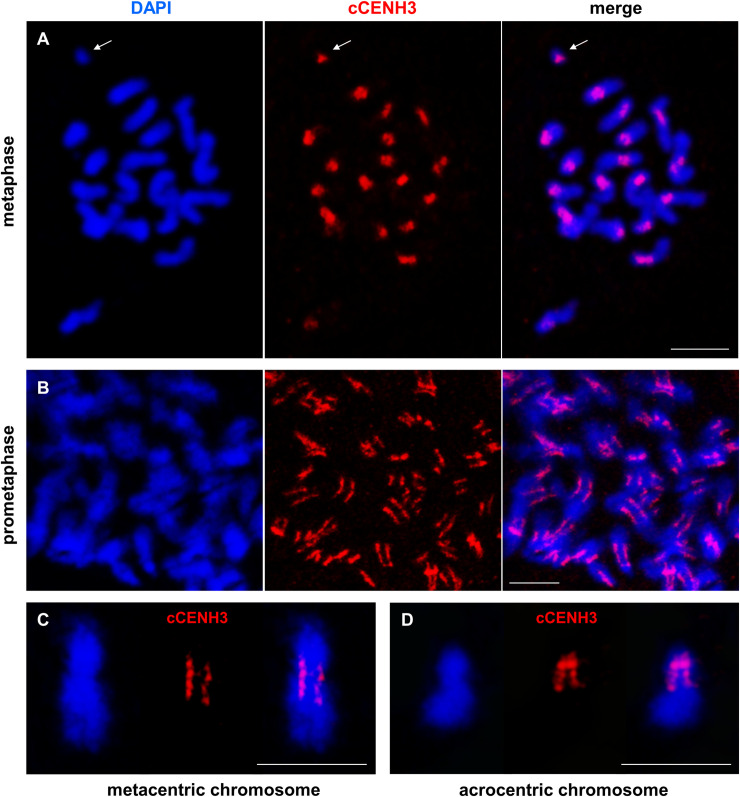
Localization of cCENH3 protein on Tribolium castaneum chromosomes.The position of cCENH3 protein (shown in red) was determined on T. castaneum chromosomes (shown in blue) by immunodetection using cCENH3 antibody. (A) On metaphase chromosomes cCENH3 localizes to the primary constrictions of all chromosomes including the minute yp chromosome (marked by an arrow). (B) Prometaphase chromosomes show extended cCENH3-containing regions with bead-like signal patterns composed of multiple cCENH3-containing domains. Enlarged view of metapolycentromeres with cCENH3-containing domains separated by cCENH3-lacking segments is shown at metacentic (C) and acrocentric (D) chromosome. The chromosomes are counterstained with DAPI. Scale bars = 5 μm.